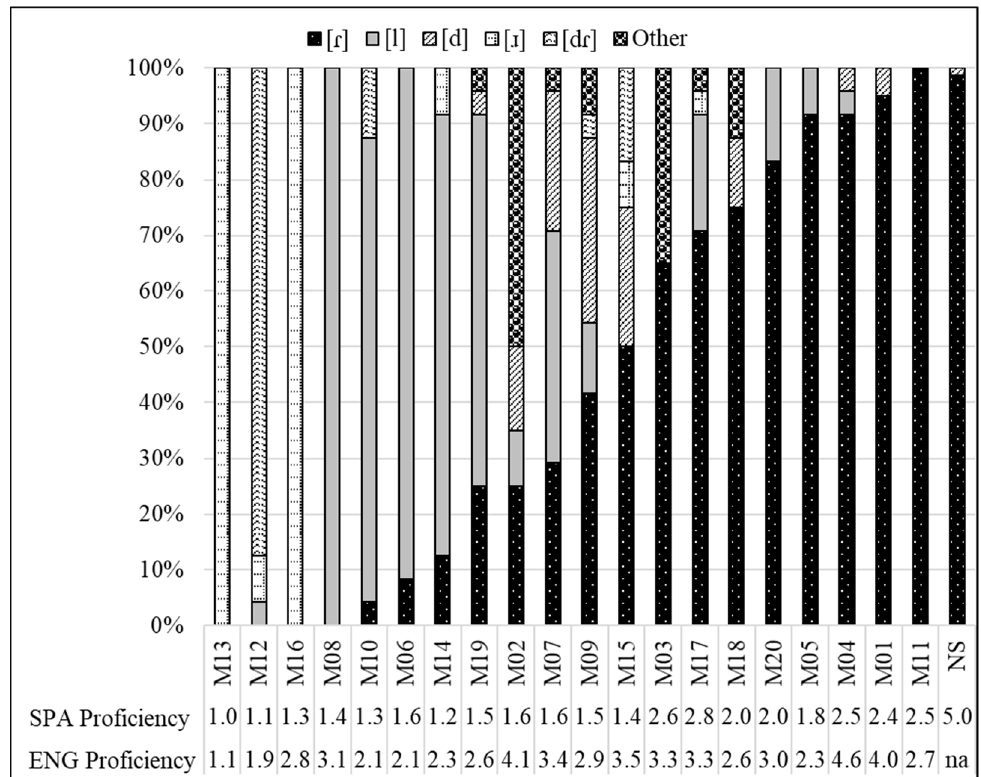
Figure 2. Percentage realization of each segment for the Spanish tap target, as produced by L1 Mandarin–L2 English–L3 Spanish speakers (M01–20) and native Spanish speakers (NS; average results presented in the final column). Results are ordered by percent accuracy of L3 tap production, from lowest to highest. ‘Other’ refers to [ ], [ð], [r], or